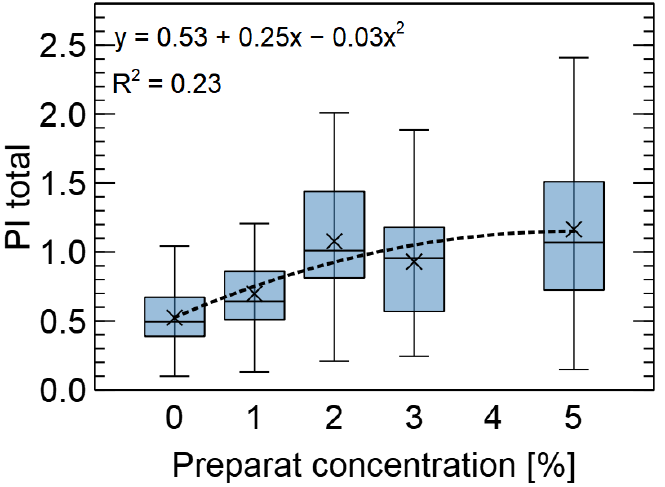
Figure 2. Photosynthesis efficiency (PI total) versus silicon concentration, for the measurements of pines’ needles. The dashed curve represents the linear regression fit of the data. The regression equation with the fitted parameters and the model’s R 2 values are printed in the figure. The regression parameters are statistically significant at p < 0.0001. In the plot, boxes span from the 1st to 3rd quantile, with the median indicated by a line, whiskers indicating a 1.5 inter-quantile range, and the × symbol indicating the mean